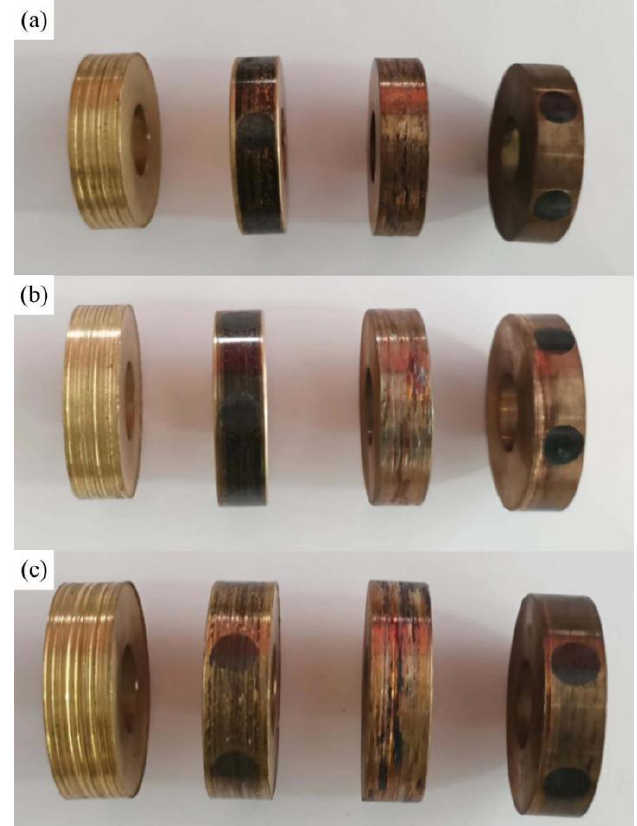
Figure 1. Image of samples under different loads: ( a ) 100 N, ( b ) 300 N, ( c ) 500 N.